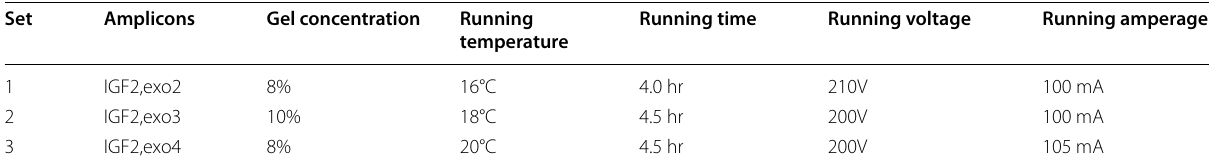
20 (L W) cm diameters polyacrylamide × ×